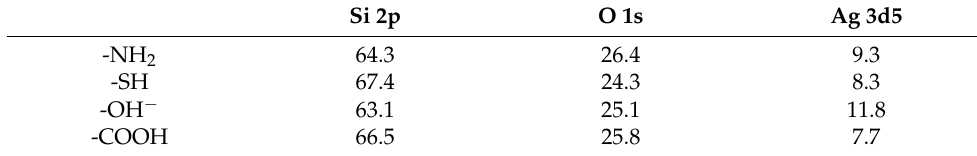
Table 3. Elemental analysis by XPS of various Ag-coated nano-SiO 2 .